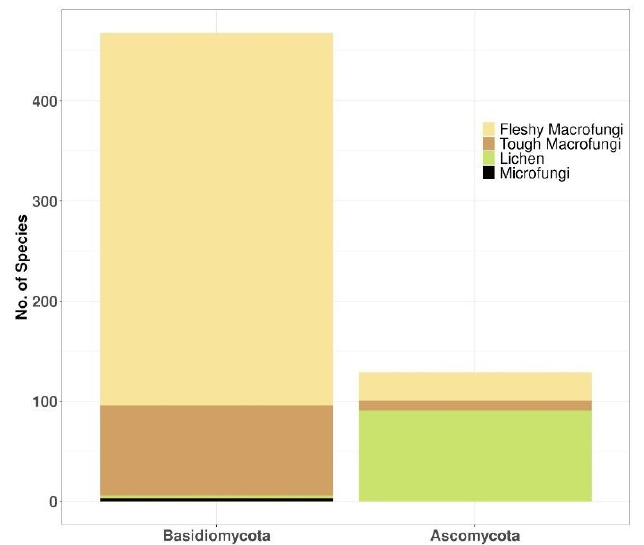
Figure 5. Number of species assessed on the Red List according to growth form among two taxonomic groups: Basidiomycota and Ascomycota (n = 597).